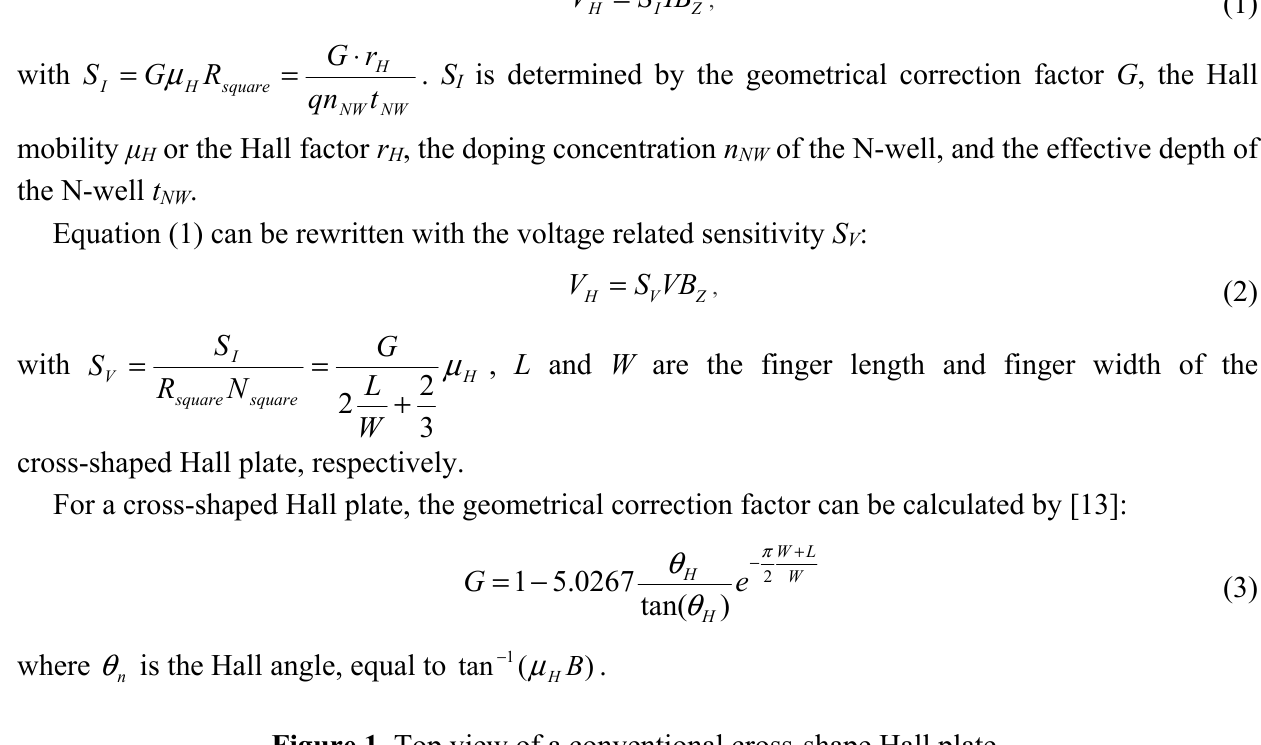
Figure 1. Top view of a conventional cross-shape Hall